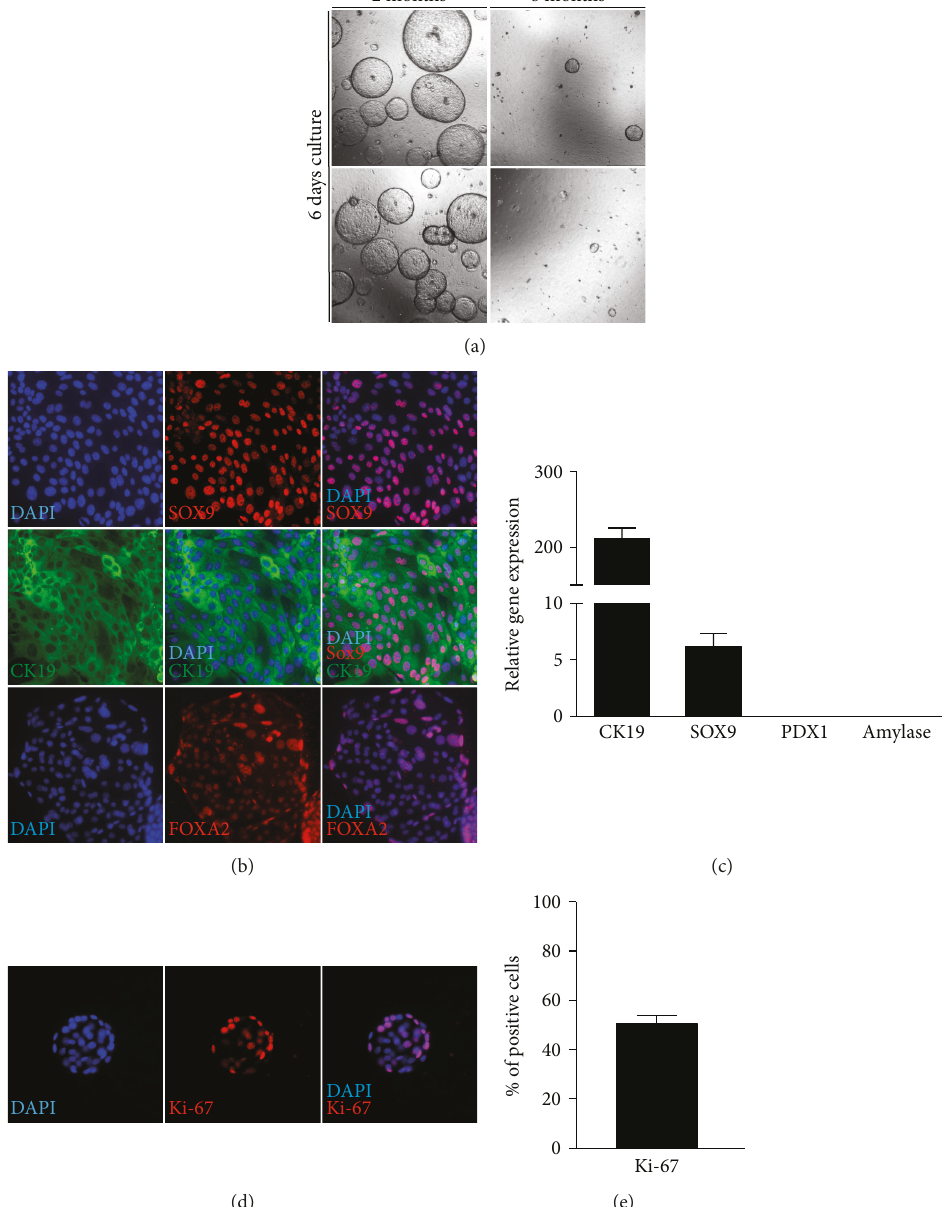
Figure 1: Pancreas mouse organoids exhibit ductal origin. (a) Organoid size and numbers are depending on the age of the host, with decreased numbers and size when generated from eight compared to two months old WT mice. Organoids shown are low passages 5-7 (40x magni fi cation). (b) Organoids are positive for CK19, FOXA2, and SOX9 (200x magni fi cation). (c) Relative gene expression levels of ductal markers (CK19 and SOX9) and lack of expression of acinar and islet cell markers amylase and PDX1. Gene expression is normalized to HMBS. (d) Ki-67 immuno fl uorescence (200x magni fi cation). (e) 49.7% of the cells are positive for Ki-67 in WT